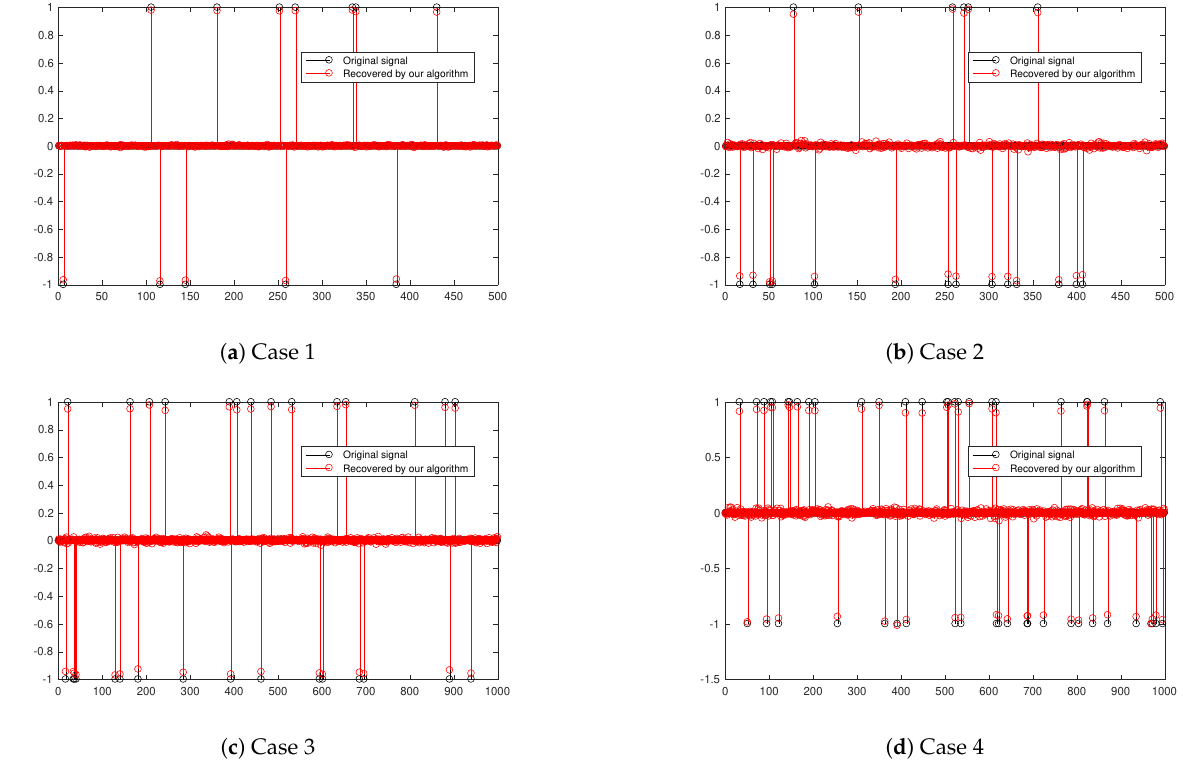
Figure 9. Recovery result by using Algorithm 2 in Example 2.